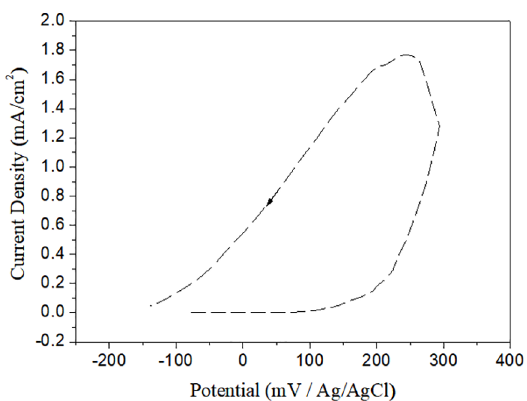
Figure 9. Cyclic polarization curves of tempered SMSS sample in 0.1 mol/L NaCl aqueous solution at 1 mV/s. Representative curves of the OCP evolution with the immersion time for the tempered SMSS sample are presented in Figure 10. Transient currents may be observed for the tempered sample and are indicated by arrows in Figure 10.